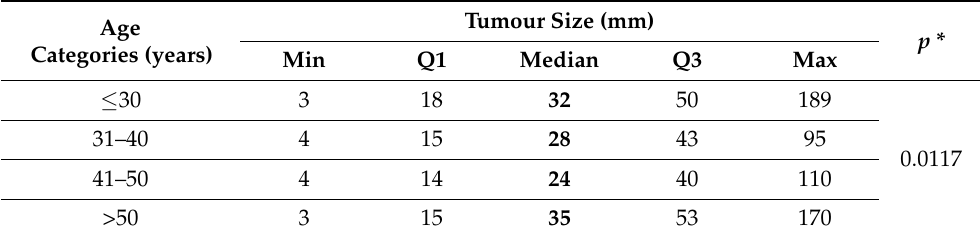
Table 14. Distribution of tumour sizes stratified by age categories in all patients with testicular neoplasms (SE, NS, BT, OM).